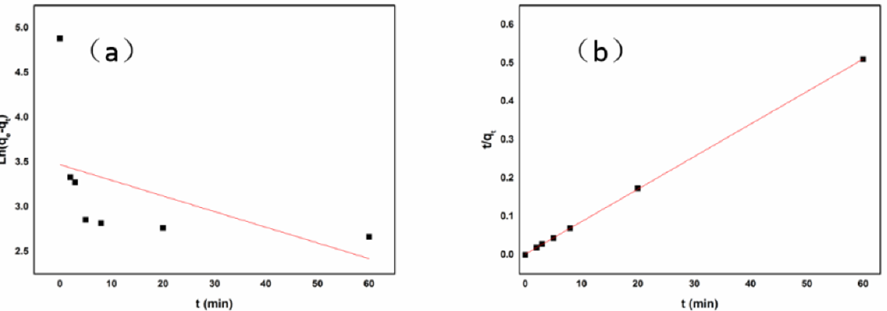
Figure 11. The Cr(VI) adsorption kinetics of Fe/CA.